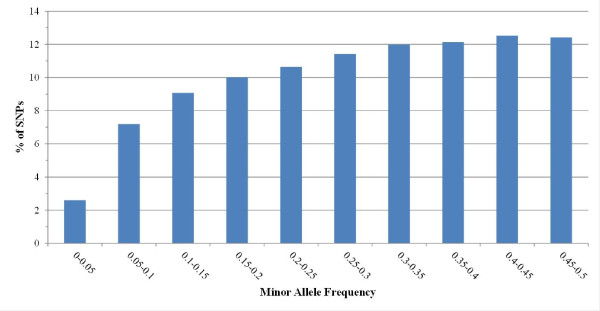
The distribution of SNPs across the genome as a function of the minor allele frequency (MAF). The percentage of SNPs that passed quality control (QC) for different MAF bins is depicted here.